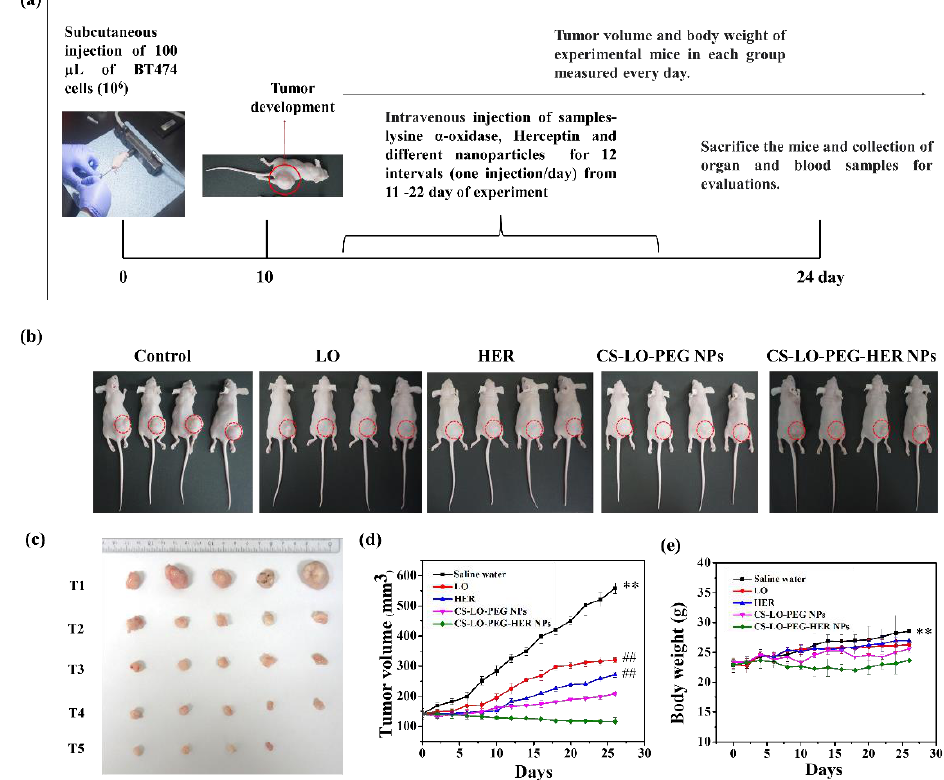
Figure 6. Effect of L-lysine α -oxidase, herceptin and different nanoparticles treatment on tumor bearing mice. Schematic illustration of in vivo antitumor study plan ( a ). Photographic visualization of tumor development ( b ), measurement of tumor volume in 24th day ( c ), tumor volume variation in relation to days ( d ) and body weight response to days ( e ). Where CS is chitosan, LO is L-lysine α -oxidase, PEG is polyethylene glycol 600, HER is herceptin (Trastuzumab). (T1) saline water (PBS), (T2) LO (200 µ g/kg), (T3) HER (200 µ g/kg), (T4) CS-LO-PEG NPs (200 µ g/kg), and (T5) CS-LO-PEG- HER NPs (200 µ g/kg). ** indicated the p < 0.01 significant variations between the untreated (saline water) mice with all other treated groups. ## indicated the non-significance with LO and HER while it exhibited the significance with other treatments and saline water ( p <